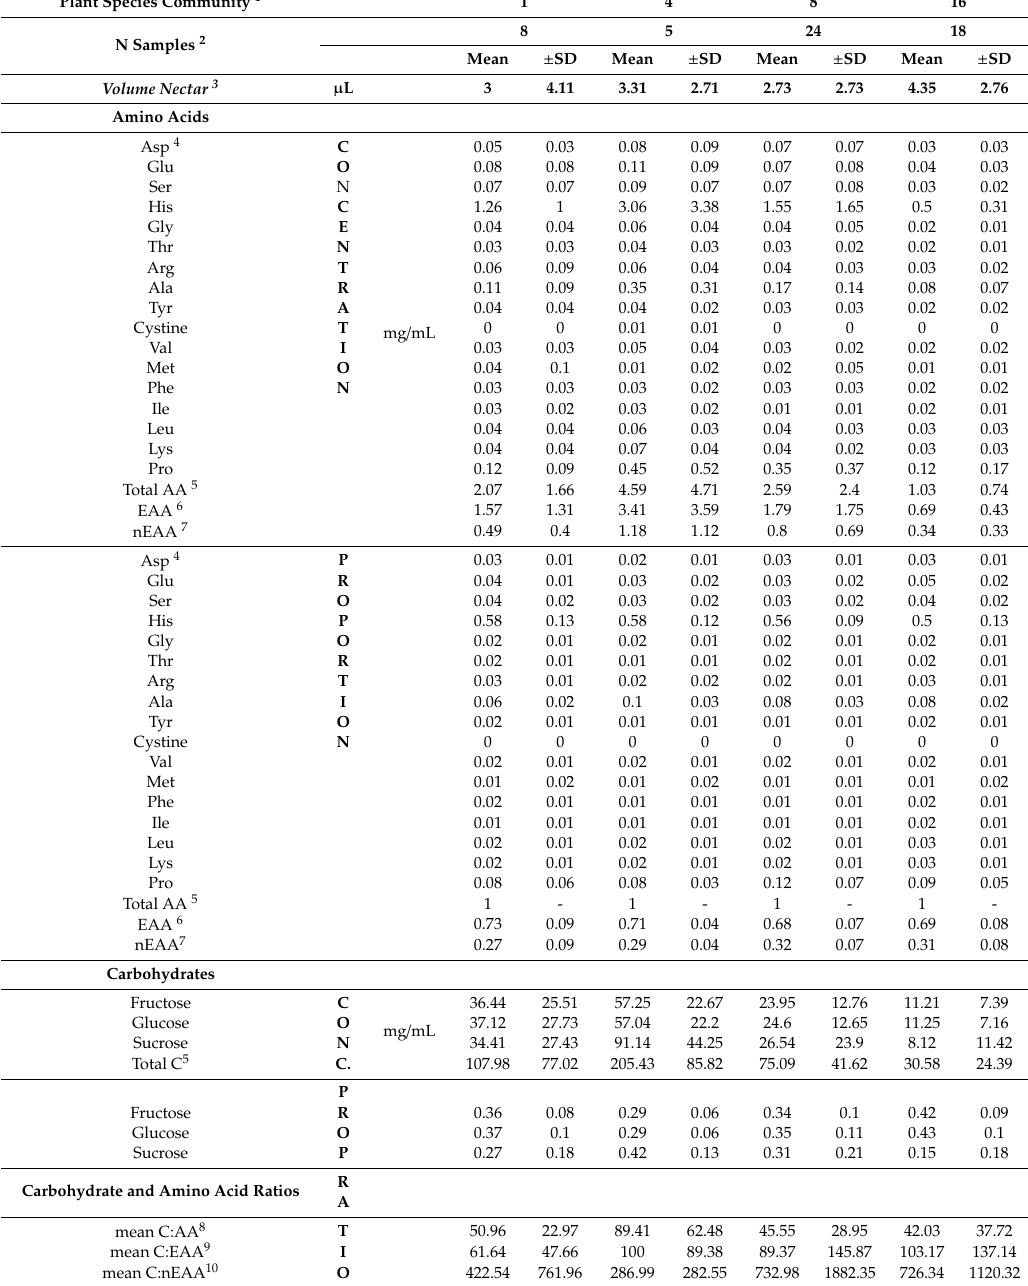
Table 1. Nectar volume, concentration (mg / mL), proportion, and ratios of chemical components, such as amino acids and carbohydrates shown here as mean per plant species level with standard deviation